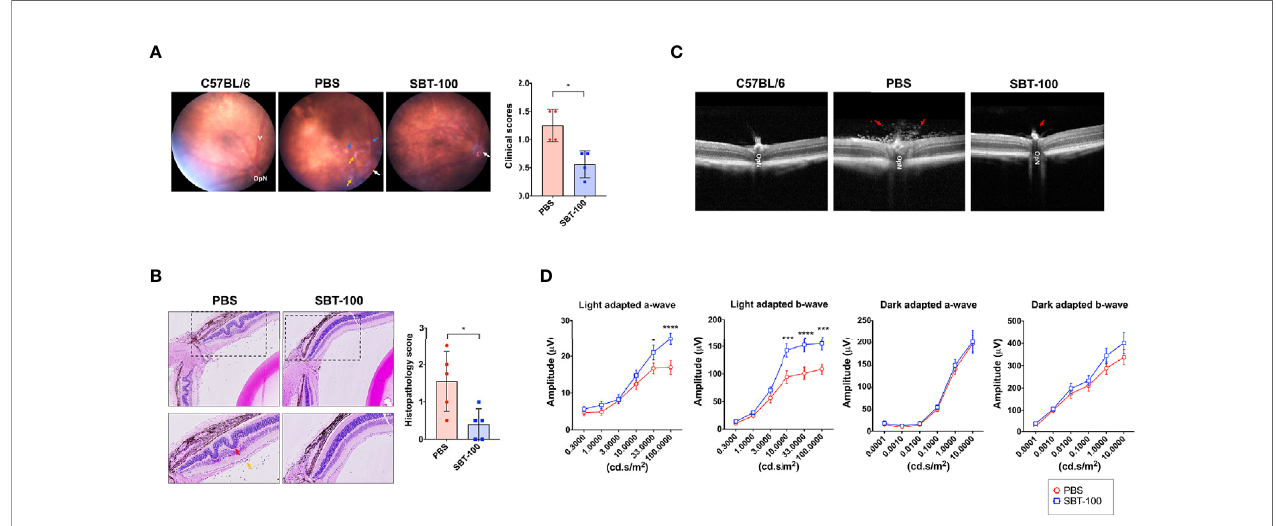
FIGURE 4 | SBT-100 treated T cells are defective in transferring EAU to naive mice. T cells from lymph nodes and spleen of PBS-treated or SBT-treated mice with EAU were reactivated with IRBP 651-670 peptide and adoptively transferred (i.p.) to unimmunized C57BL/6J mice. Twelve days after cell transfer, disease was assessed by fundoscopy (A) , histopathology (B) , OCT (C) , and ERG (D) . For the data shown, n = 5 mice. All data represent at least three independent experiments and presented as mean ± SEM. (* p < 0.05; *** p < 0.001; **** p <